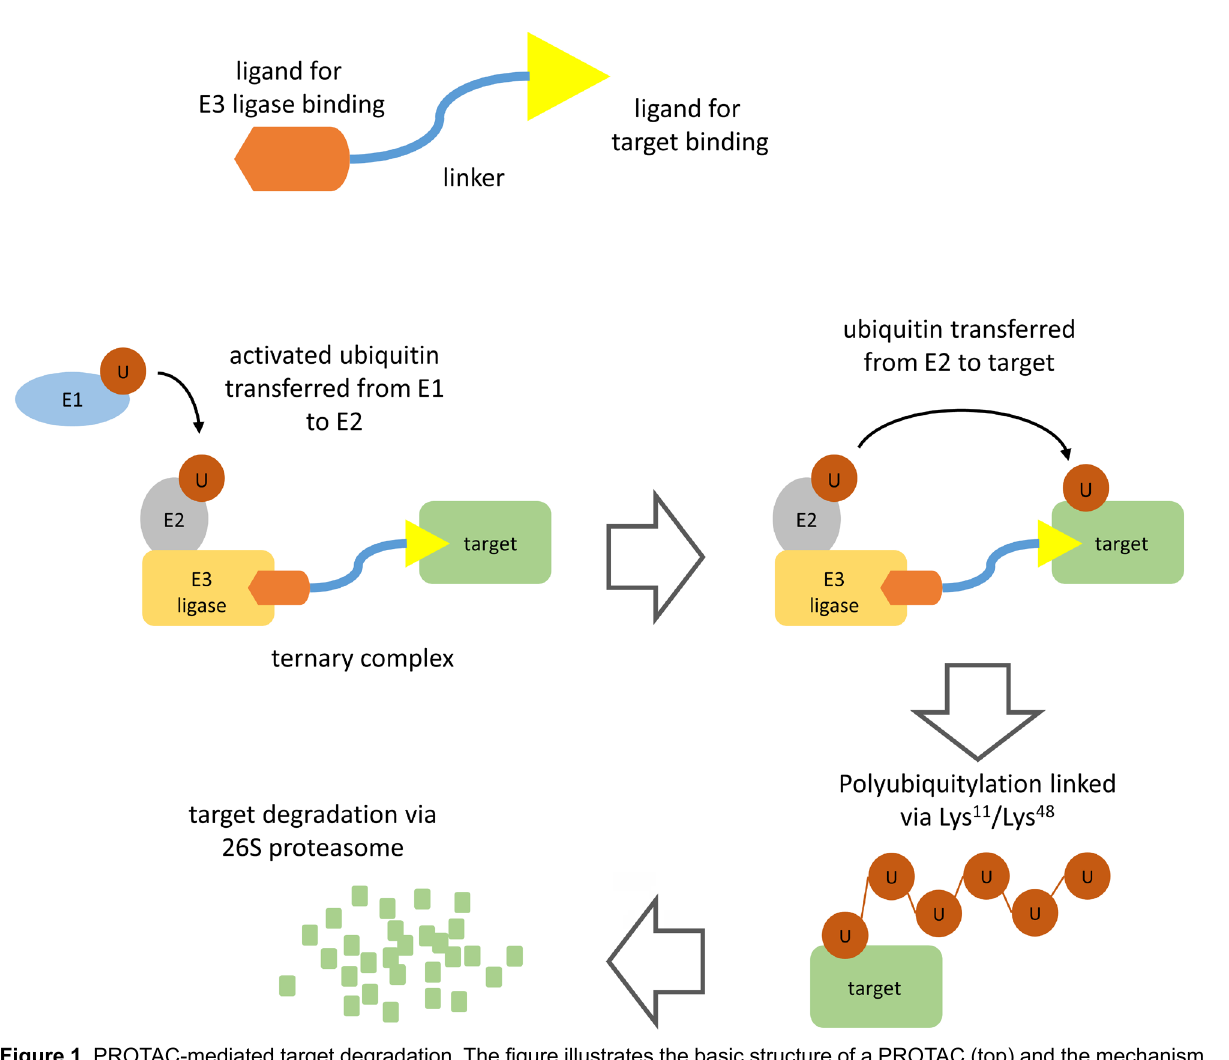
Explor Target Antitumor Ther. 2020;1:131-52 | https://doi.org/10.37349/etat.2020.00009